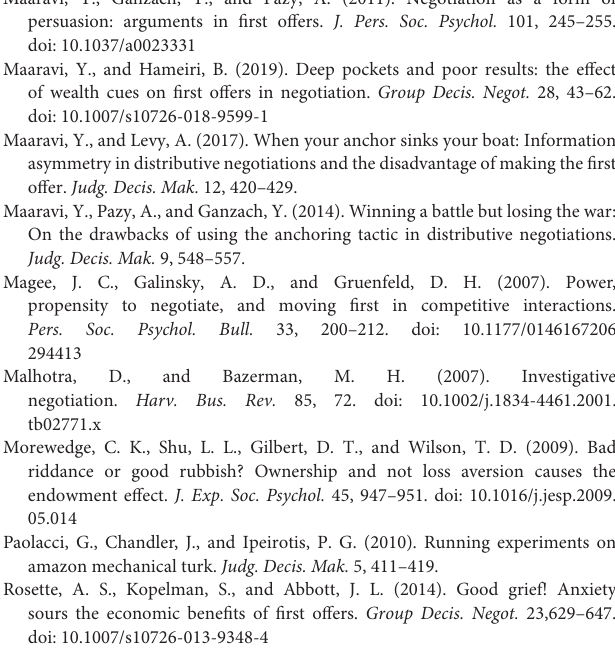
bargaining table? The influence of gender and framing on the initiation of negotiation. J. Pers. Soc. Psychol. 93, 600–613. doi: 10.1037/0022-3514.93.4.600